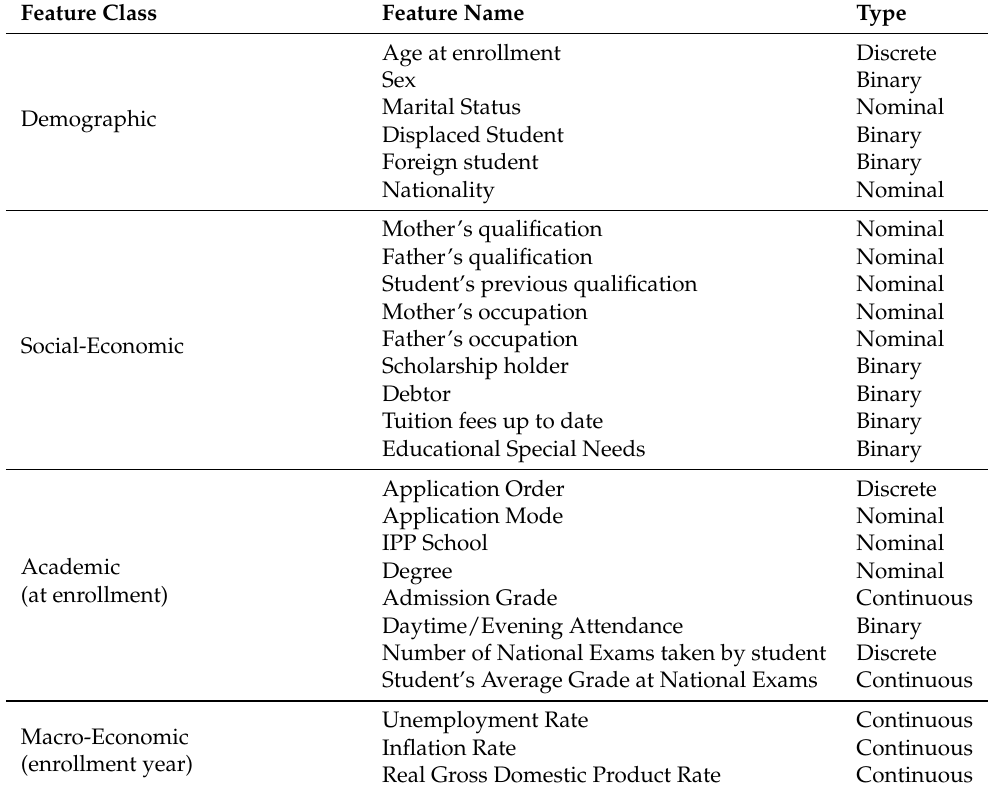
Table 1. Summary of features for the base dataset.